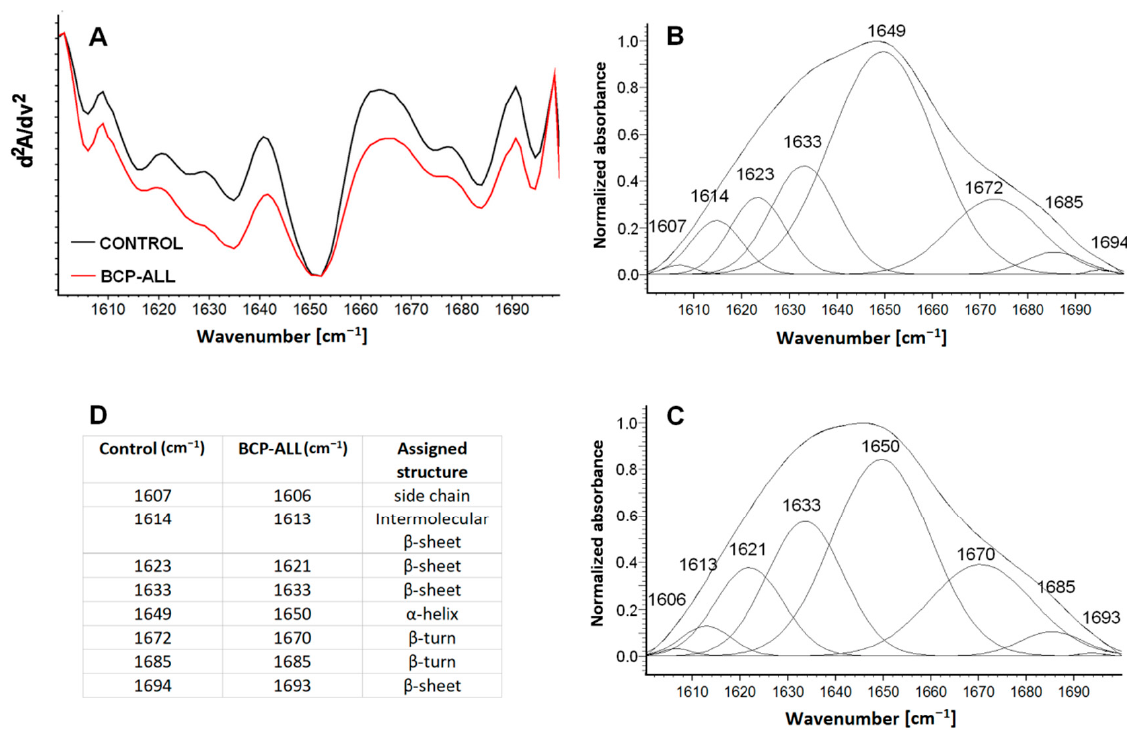
Figure 2. The second derivative ( A ) for the control samples (black line) and for the BCP-ALL samples (red line) and the curve-fitting analysis in the amide I region in the control samples ( B ) and in the BCP-ALL samples ( C ). Assignement of individual components to various protein secondary structures is described in table ( D ).